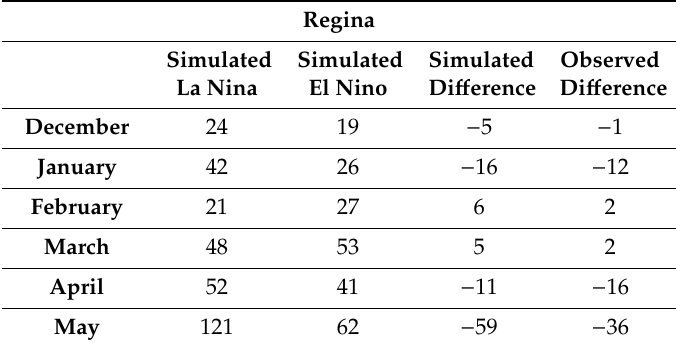
Figure 6. Gridded 10 km resolution observed (ANUSPLIN) total precipitation (mm) differences Table 1. Changes in precipitation (mm) between La Niña and El Niño in simulation and observation in